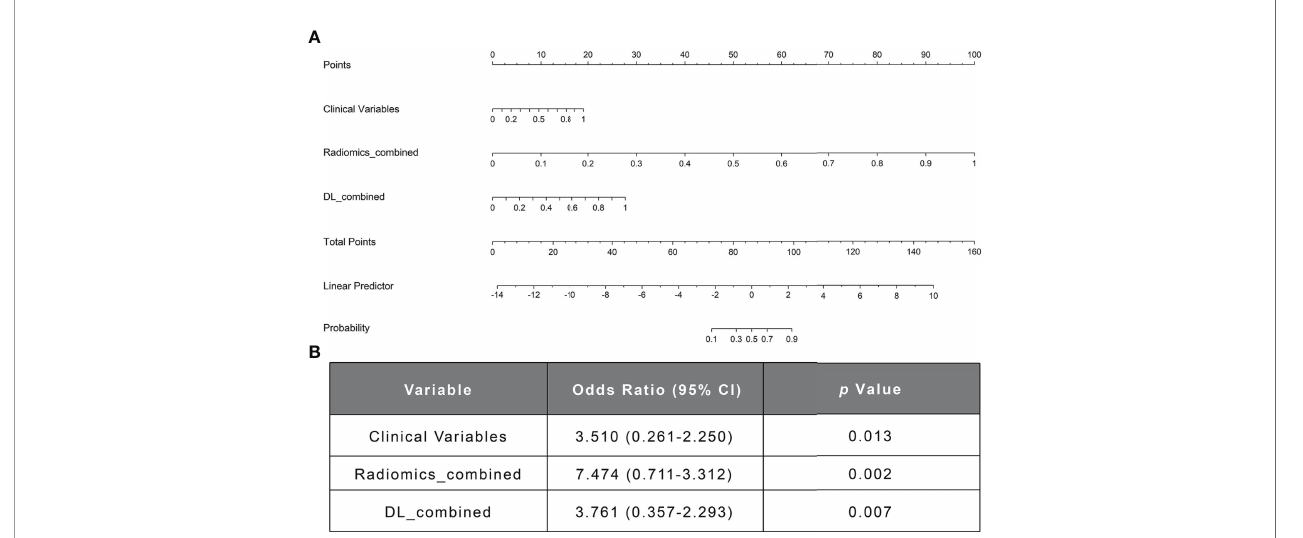
FIGURE 6 | The nomogram of the fusion model. (A) The nomogram of the fusion model combining the clinical model ’ s prediction score, the DL-based image prediction score, and the radiomics-based image prediction score. (B) The multivariable logistic regression analysis of the clinical variables, the radiomics_combined model, and the DL_combined model. DL, deep